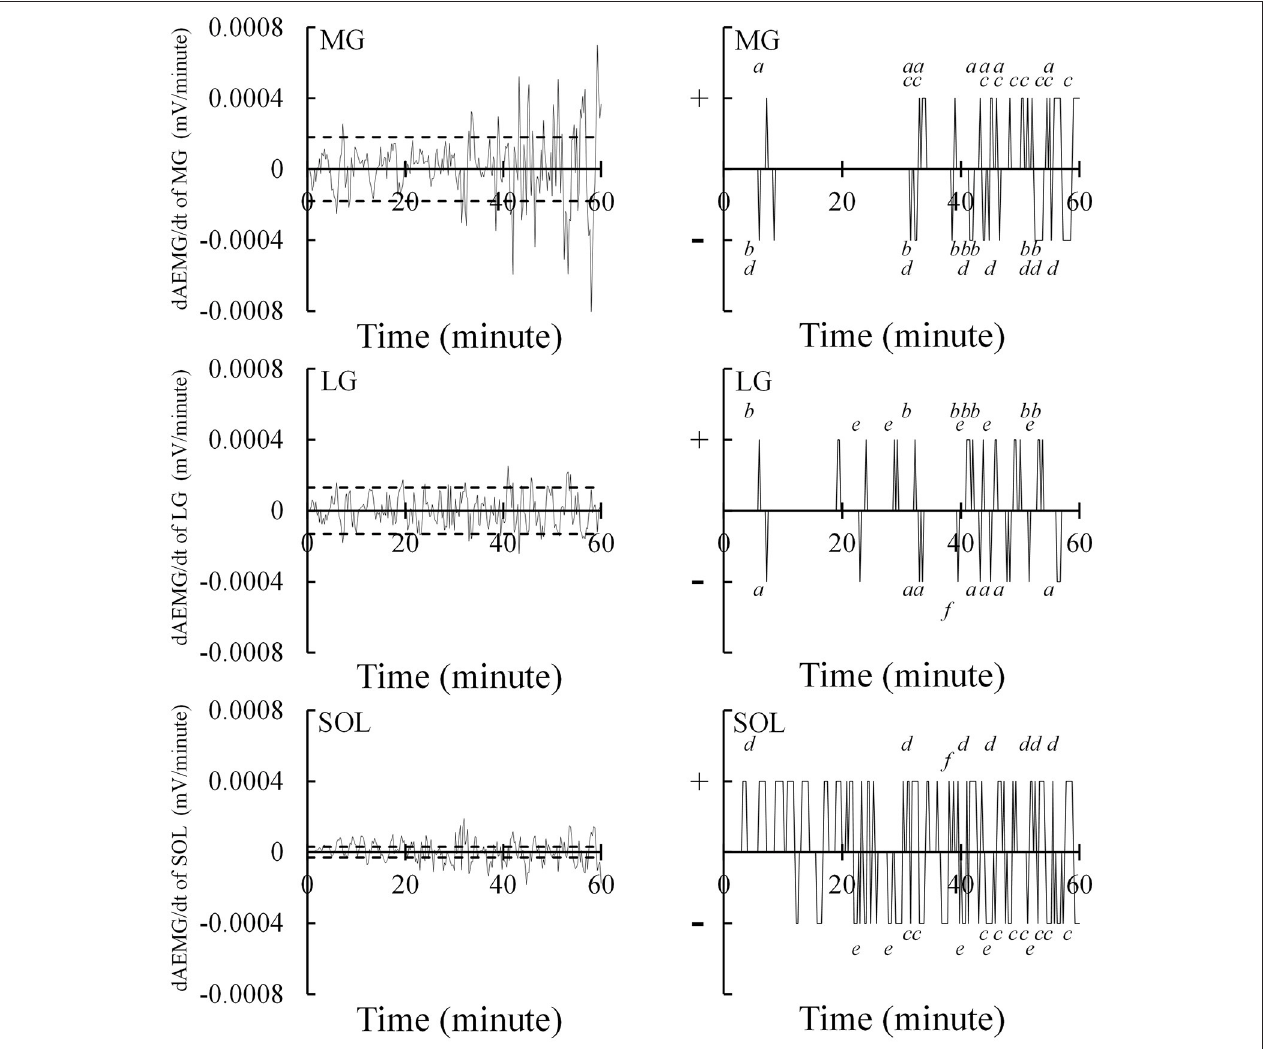
FIGURE 4 | Measuring alternate muscle activity during the 1-h fatiguing task. The 15-s averaged electromyography signals of the medial and lateral gastrocnemius muscles (MG and LG) and the soleus muscle (SOL) were smoothed by five-point moving average and differentiated (dAEMG/dt). The left figures show the time-course changes in dAEMG/dt of each muscle. Eight sample points of dAEMG/dt immediately after the onset of exercise were extracted and 3 standard deviations (3 SD s) of dAEMG/dt during this period were determined as the normal fluctuation. The dashed line indicates the ± 3 SD s. The criterion for an outlier was defined as dAEMG/dt throughout the fatiguing task that exceeded the dashed lines. As shown on the right, the extracted outliers were classified into positive ( + ) and negative ( − ) outliers per muscle. The alternate muscle activity of LG → MG, MG → LG, SOL → MG, MG → SOL, SOL → LG, and LG → SOL are indicated using a , b , c , d , e, and f ,